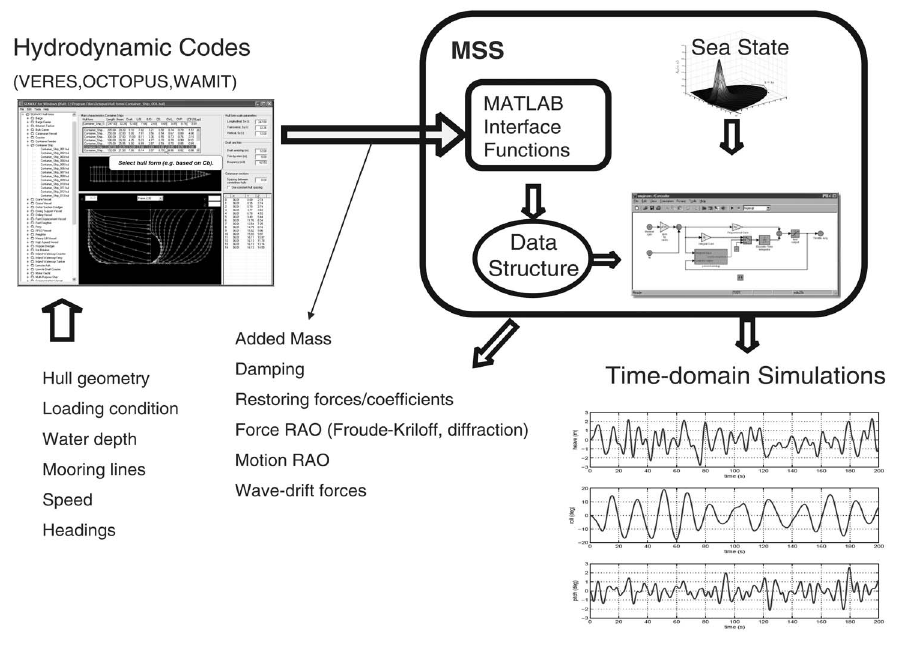
Figure 5 . Marine Hydro